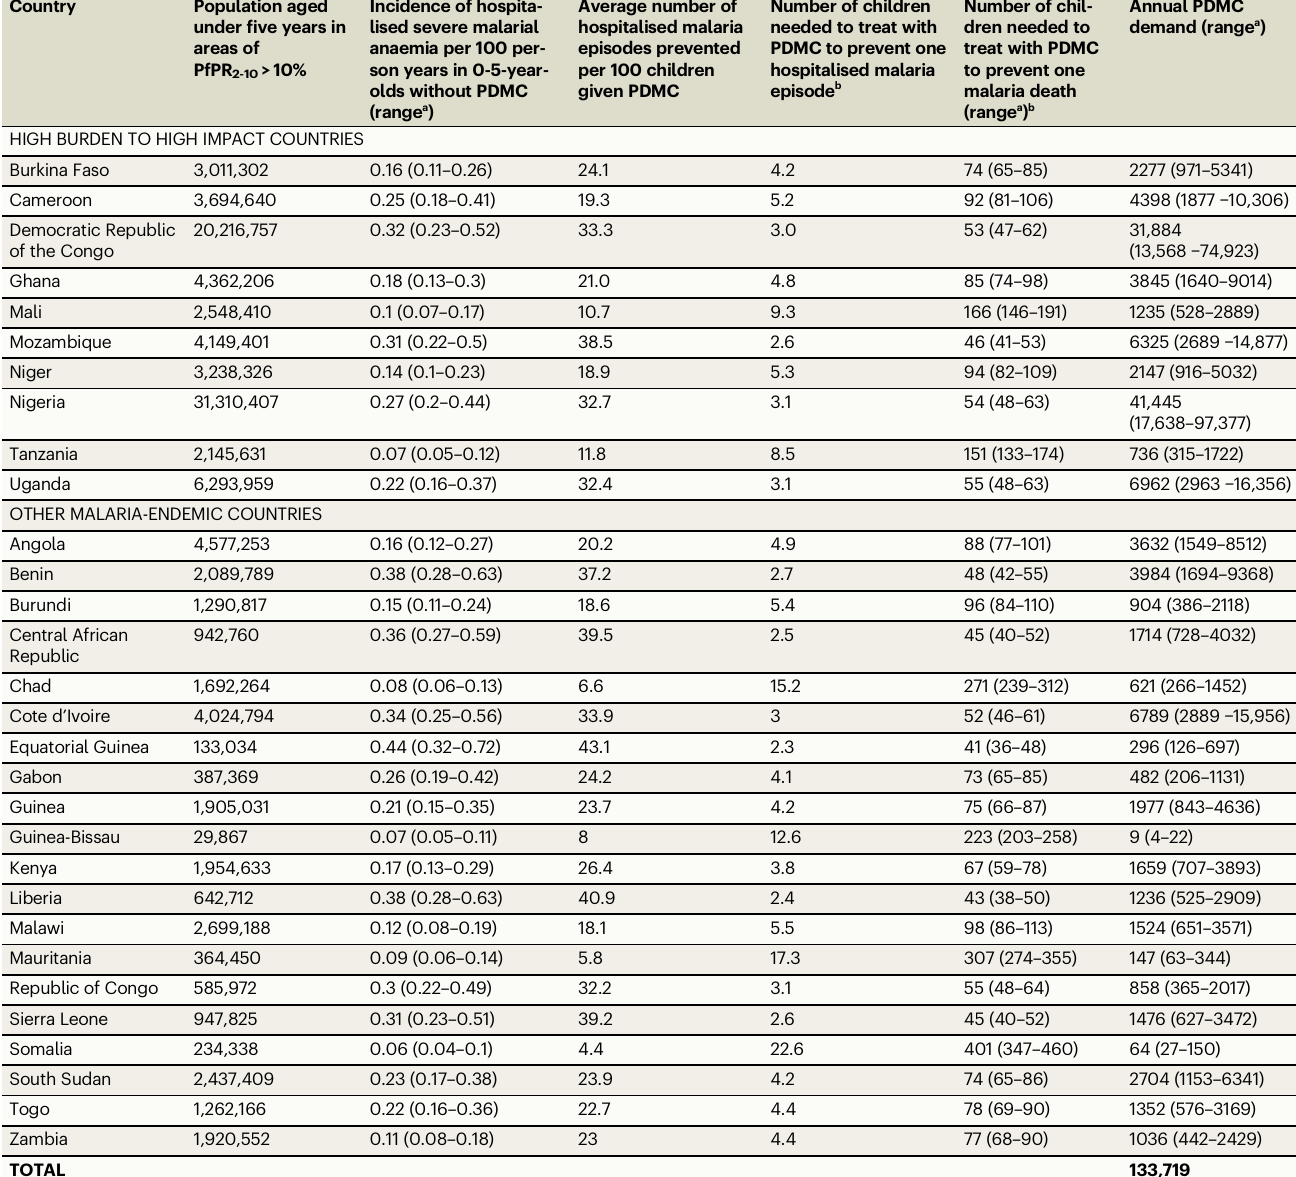
Table 1 | Estimated PDMC impact and demand in sub-Saharan African countries Country Population aged under fi ve years